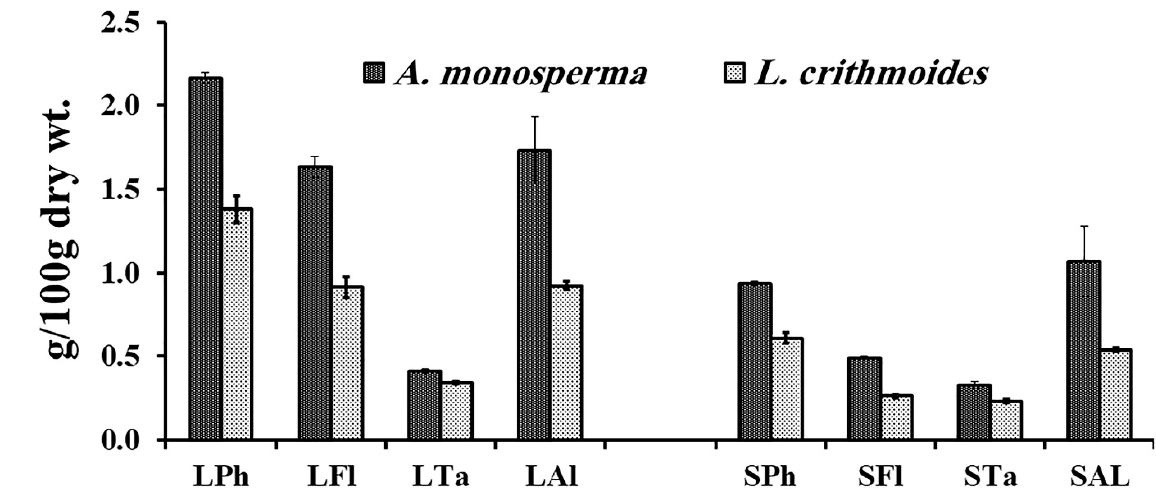
Figure 5. Phytochemical analysis of leaves and stems of A. monosperma and L. crithmoides . L = leaf, S = stem, Ph = phenols (g GAE/100 g dry wt), Fl = flavonoids (g CE/100 g dry wt.), Ta = tannins (g TAE/100 g dry wt), Al = alkaloids (g/100 g dry wt.). GAE: gallic acid equivalents, CE: catechin equivalents, TAE: tannic acid equivalents.